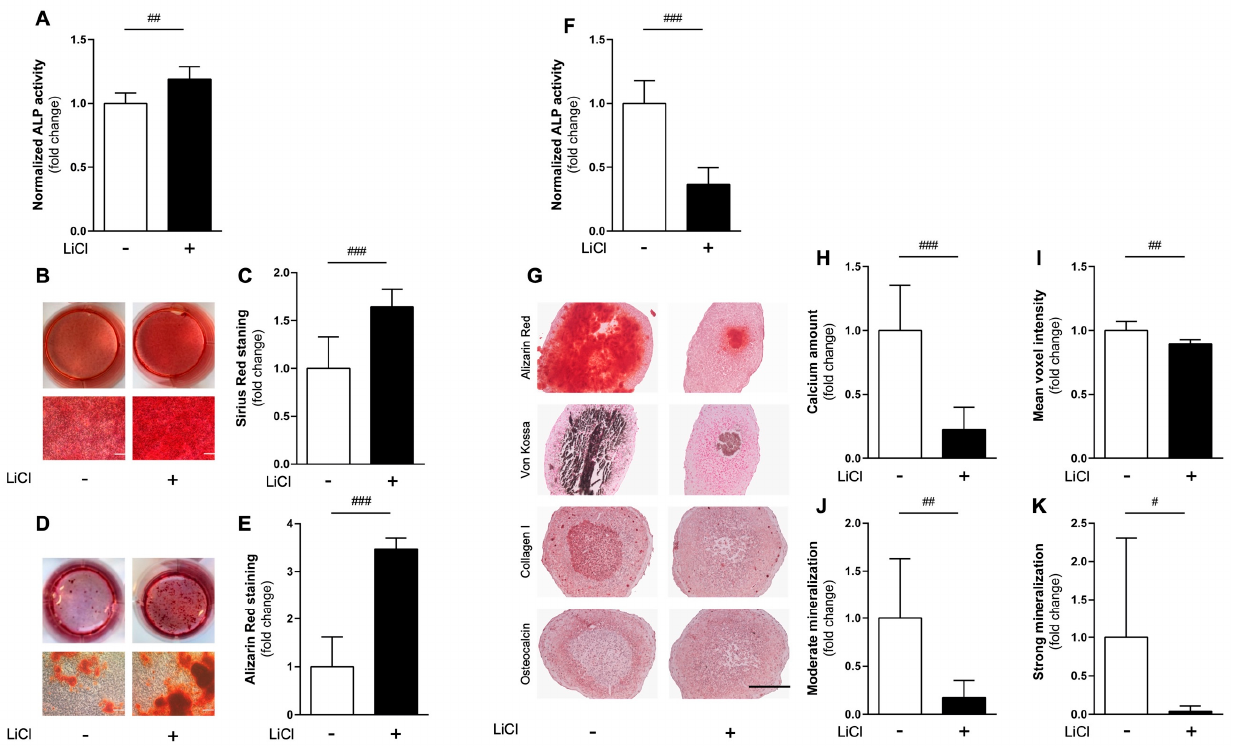
Figure 6. Different responses to cWnt agonist in monolayer and spheroid cultures. ( A – E ) Effect of LiCl on MC3T3-E1 cells cultured in 2D: determination of alkaline phosphatase (ALP) activity after 14 days of culture without (-) or with (+) 5 mM LiCl ( A ). Representative Sirius Red stainings after 21 days with macroscopic photographs of wells (top) and respective micrographs (bottom) ( B ) and corresponding spectrophotometric quantification of total collagen content upon dye extraction ( C ). Corresponding Alizarin Red staining ( D ) with quantification of calcium deposition ( E ). Scale bars show 100 µm. ( F – K ) Comparison of lithium-mediated effects in 3D-cultured MC3T3-E1 cells. ALP activity after 14 days ( F ), representative immuno-/histochemically stained sections (i.e., Alizarin Red, Von Kossa, type I collagen, osteocalcin, from top to bottom) after 21 days. Quantified extracellular calcium content in spheroids after 21 days ( H ) and corresponding micro-CT analyses: mean voxel intensity ( I ), volumetric quantification of moderate ( J ) and strong mineralization levels ( K ). For details see legend to Figure 3. Scale bars are 200 µ m. Significant differences were evaluated using Student’s t -test ( n = 6). # p < 0.05, ## p < 0.01, ### p < 0.001 as indicated. Data represent geometric mean ± 95%